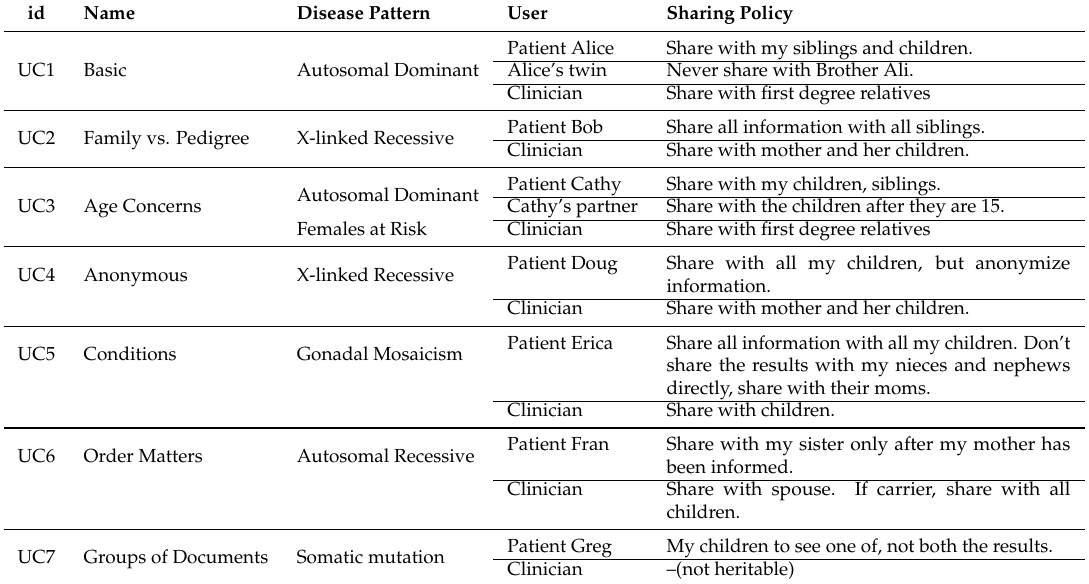
Table 1. Genetic sharing use cases with multi-party consent